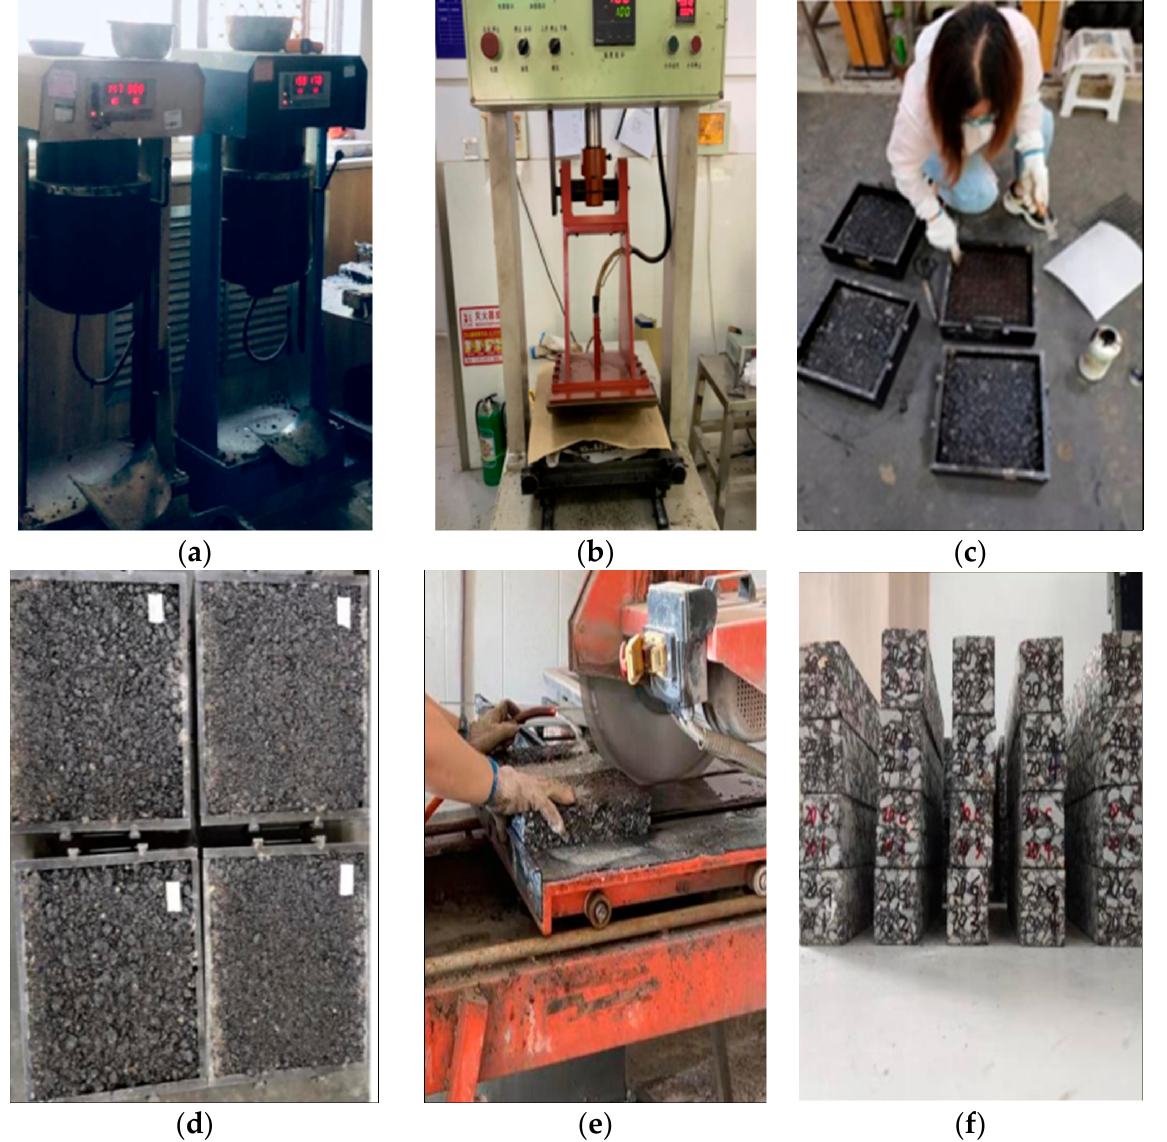
Figure 1. The preparation of test specimens. ( a ) Asphalt-mixture mixing; ( b ) layer rolling forming; ( c ) laying geosynthetics and brushing the tack coat; ( d ) double-layered asphalt slab; ( e ) plate cutting; ( f ) beam sample of the bending test.